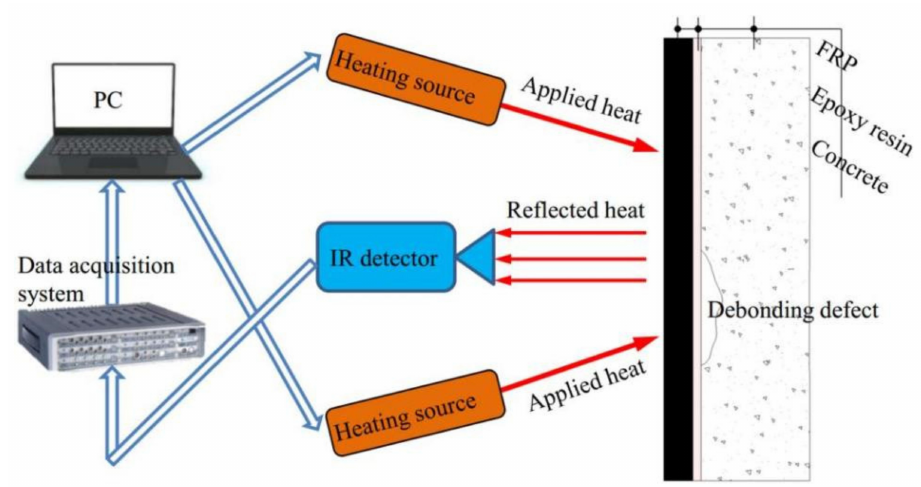
Figure 10. Reflection observation of the active IR in the EB technique